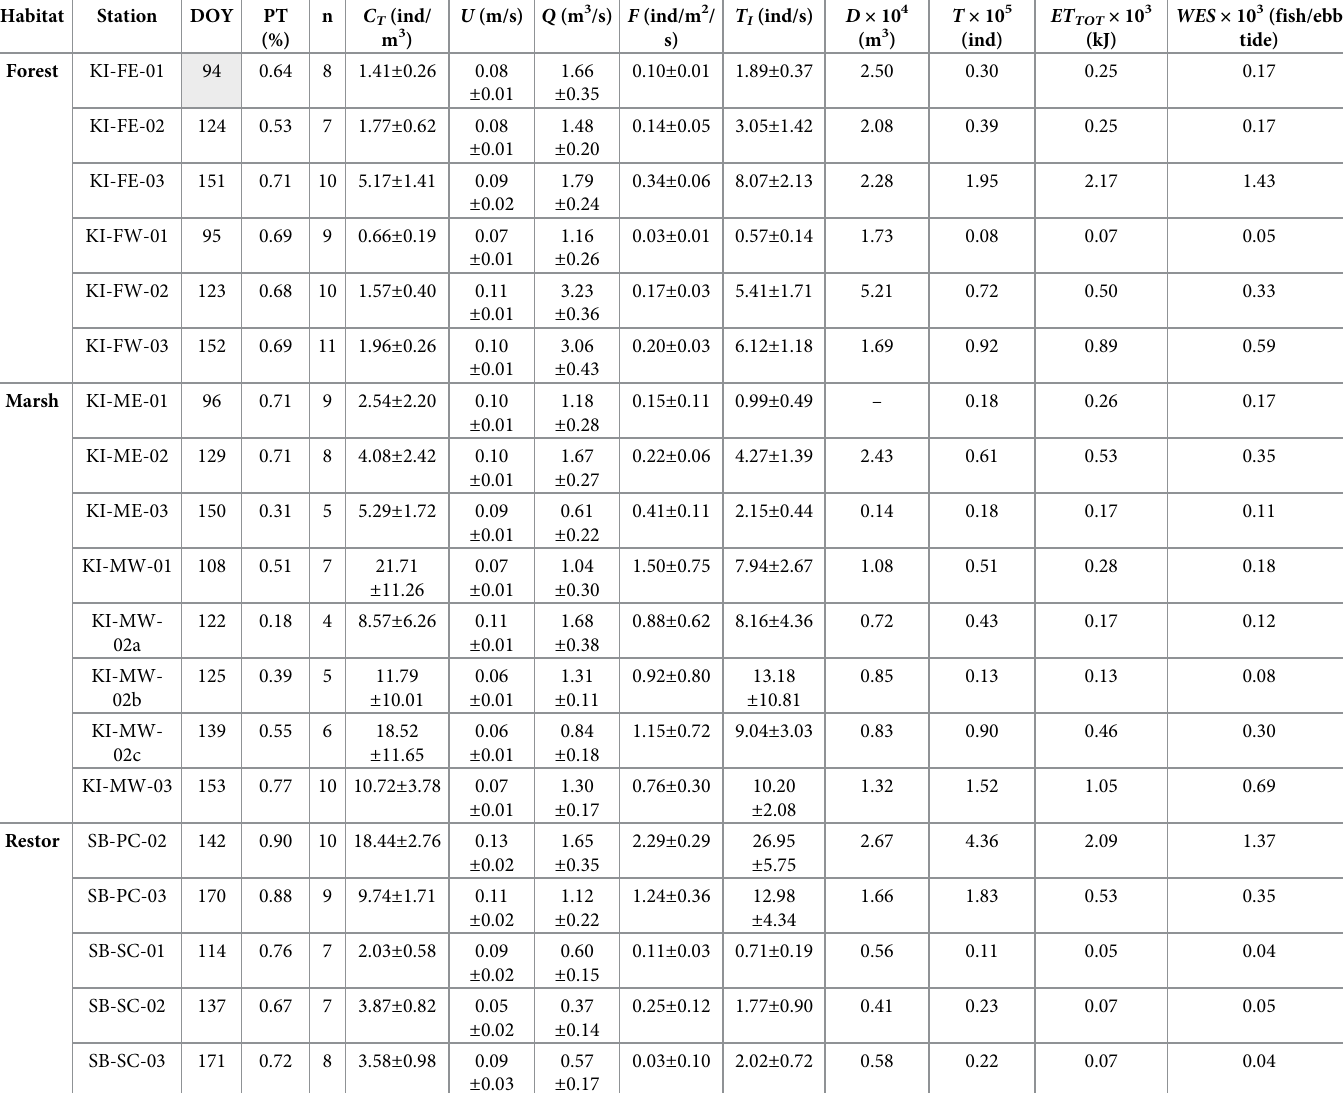
Table 3. Summary variables for 2017 sample